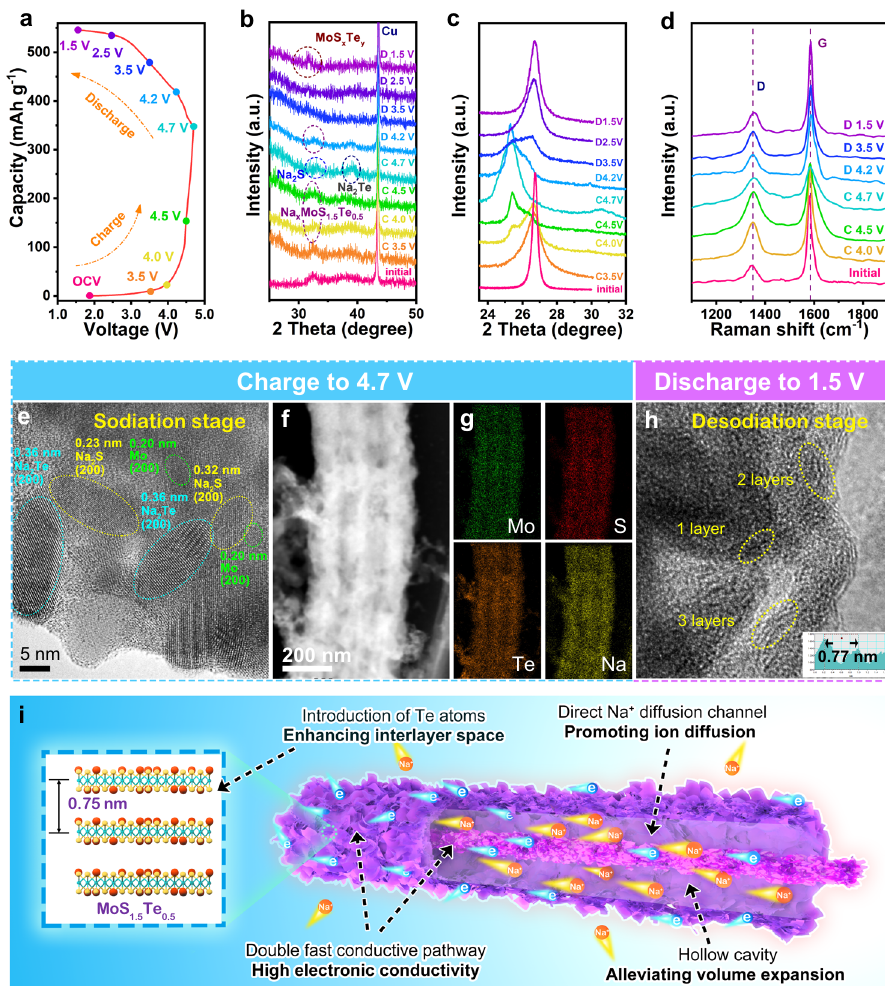
Fig. 5 Structural evolution of MoS 1.5 Te 0.5 @C nanocables anode and graphite cathode in the 1st cell charge/discharge cycle. a Charge – discharge curves of MoS 1.5 Te 0.5 @C nanocables||EG dual-ion cell marked by colorful dots in the fi rst cycle. Ex situ XRD patterns of the MoS 1.5 Te 0.5 @C nanocables anode ( b ) and EG cathode ( c ). d Ex situ Raman spectroscopy of EG cathode. e HRTEM image, f STEM image, g elemental mappings at fully charging state, and h HRTEM image at fully discharging state for MoS 1.5 Te 0.5 @C nanocables anode. The ex situ postmortem measurements were carried out on electrodes cycled using the 3 M NaPF 6 in EC/EMC/DMC (1:1:1, by volume) electrolyte solution at a speci fi c current of 0.1 A g − 1 and 25 °C. i Schematic illustration of the Na + storage mechanism and electronic conductivity in the MoS 1.5 Te 0.5 @C nanocables with stable “ nanowire-in-nanotube structure ” Fig. 5b demonstrate the structural reversibility during the charging-discharging process. Before charging, at the position of open-circuit voltage (OCV), one re fl ection at 32.5° could be attributed to (100) crystal planes of MoS 1.5 Te 0.5 . With a con- tinuous charging process, the re fl ection shifts to 32.9°, indicating the formation of Na x MoS 1.5 Te 0.5 . When the voltage reaches 4.7 V, two re fl ections at 33.3° and 39.5° (marked by the circle) can be detected, which could be indexed to the crystals of Na 2 S and Na 2 Te, respectively, revealing the conversion evolution from Na x MoS 1.5 Te 0.5 into Na 2 S and Na 2 Te 51 – 53 . Besides, one can see one re fl ection at 31.5° assigning to the (100) crystal plane of MoS x Te y at the end of the discharging process, suggesting the process is reversible. Importantly, the re fl ection (100) has slightly shifted to a lower angle than that of the pristine one, which could be accountable for an increased interlayer spacing for the Na + inserting and releasing process.